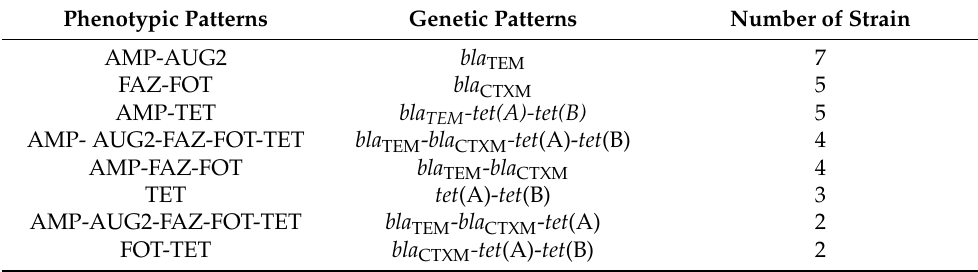
Table 2. Antibiotic resistance patterns of E. coli from